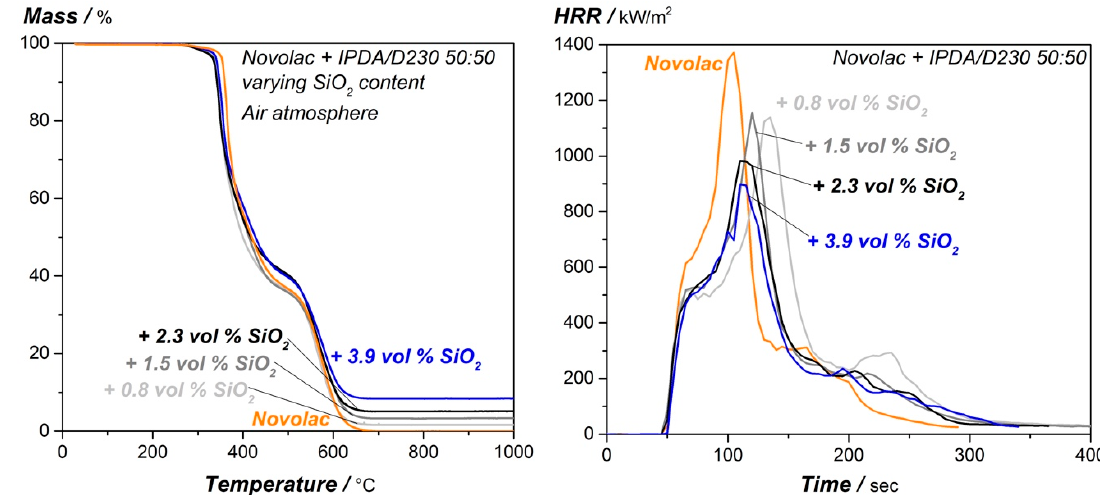
Figure 4. TGA measurement under air atmosphere (left) and cone calorimeter test (right; 50 kW/m 2 and distance sample to heater: 60 mm) of the silica modified epoxy resin. Table 4. T d5% , residual mass @700 ◦ C and @900 ◦ C from TGA under air atmosphere and time to ignition (tti), peak heat release rate (pHRR) and total heat release (THR) from cone calorimeter experiments